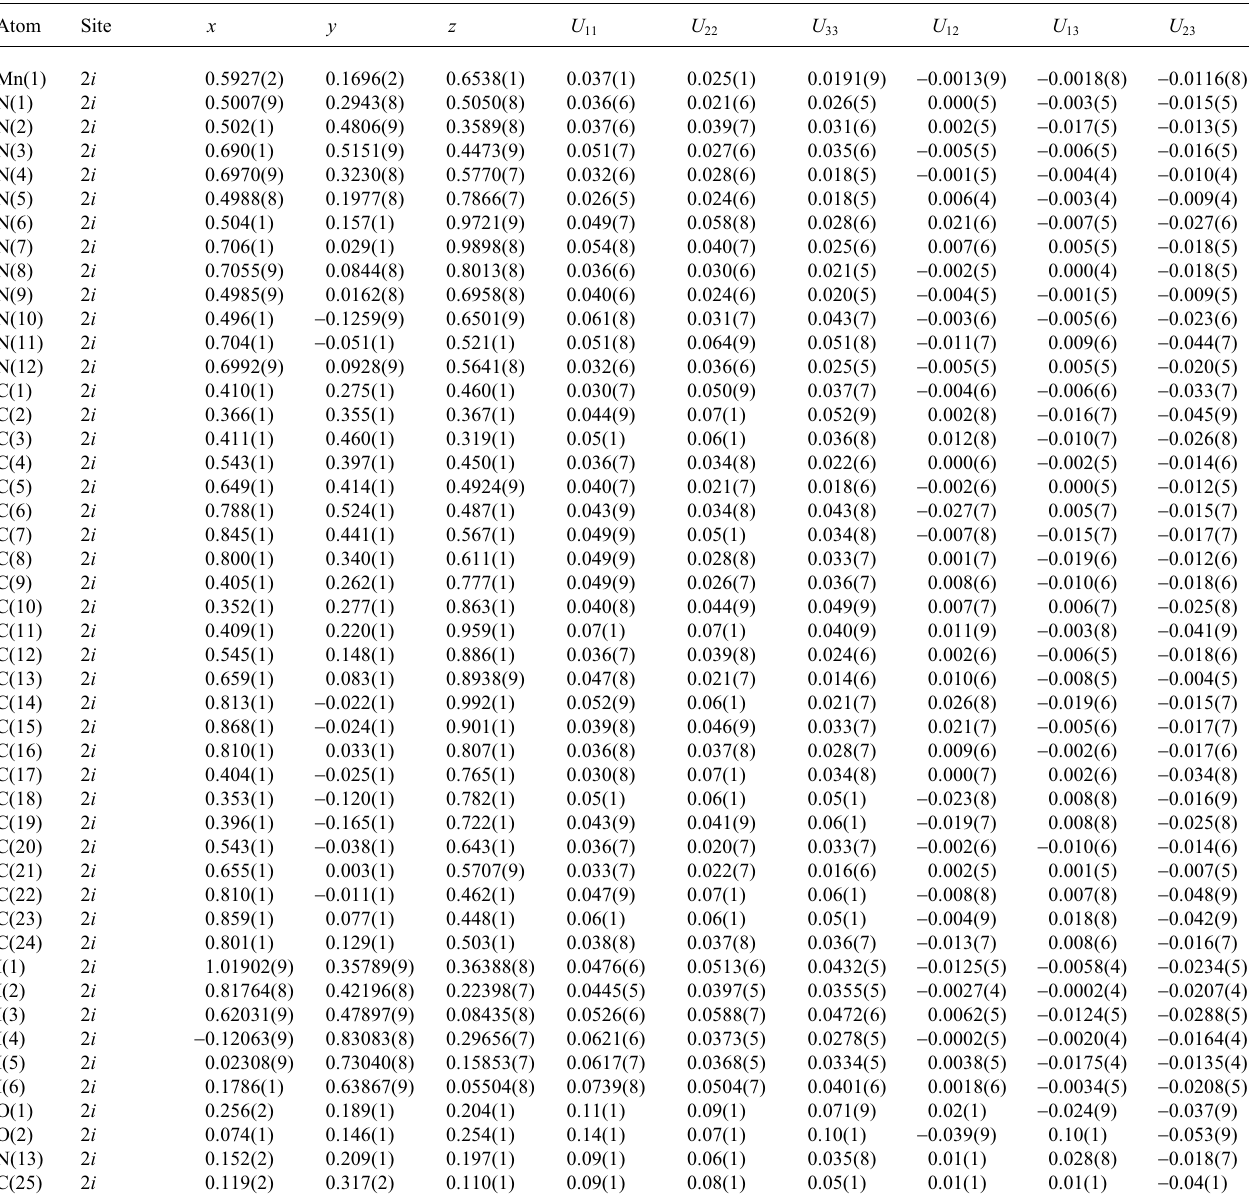
Table 3. Atomic coordinates and displacement parameters (in Å 2 ).